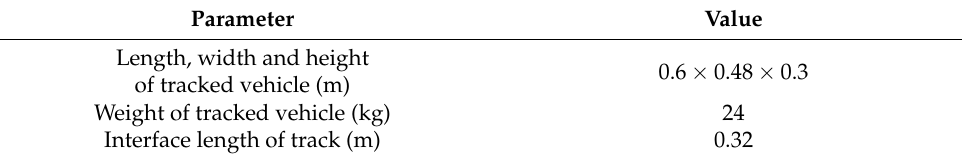
Table 4. Specifics of the tracked vehicle.